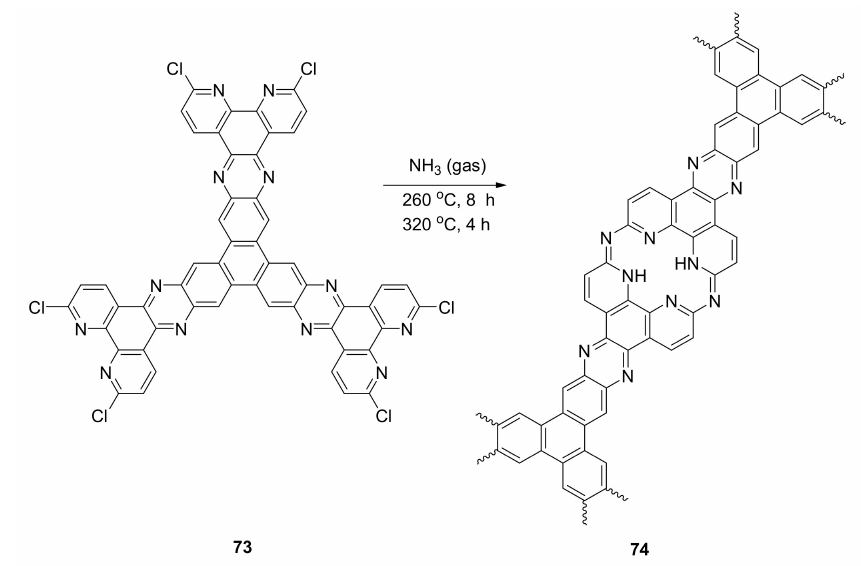
Figure 13. Solvent- and catalyst-free synthesis of macrocycle-linked covalent organic frameworks.